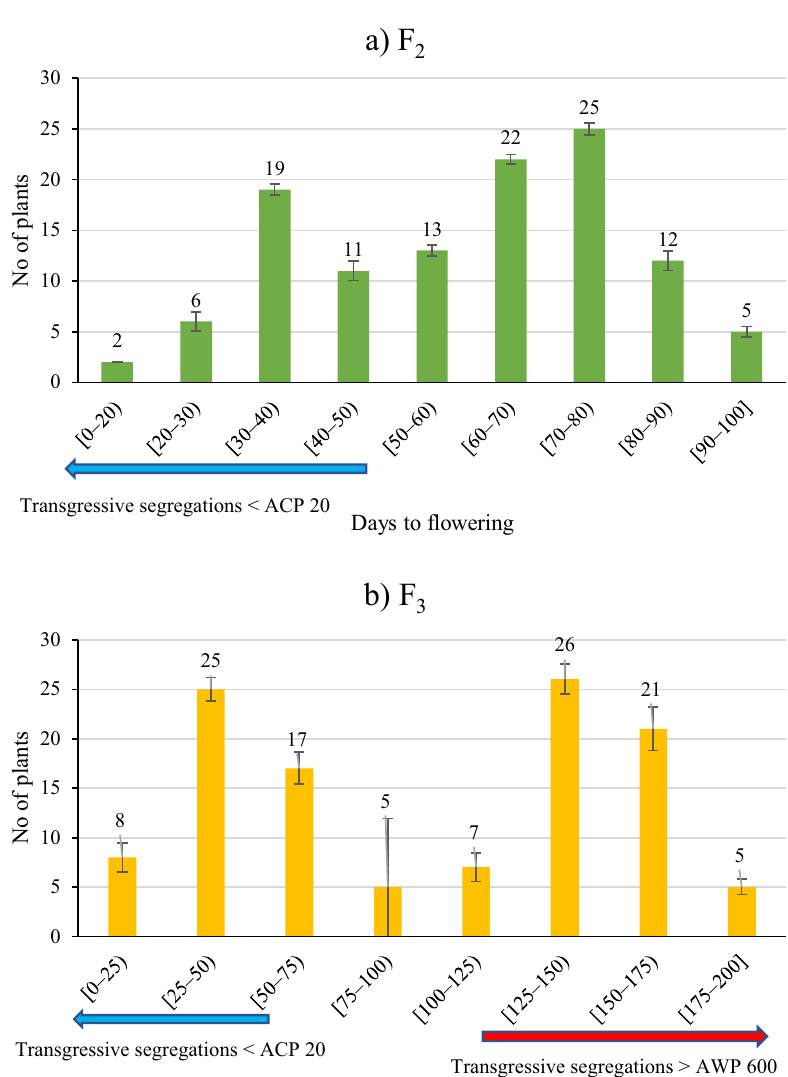
Figure 3. Frequency distribution of days to flowering in F 2 ( a ) and F 3 ( b ) populations. Transgressive segregations were shown by arrows (blue and red colors). De novo super-early progeny are earlier than the earliest parent (Blue